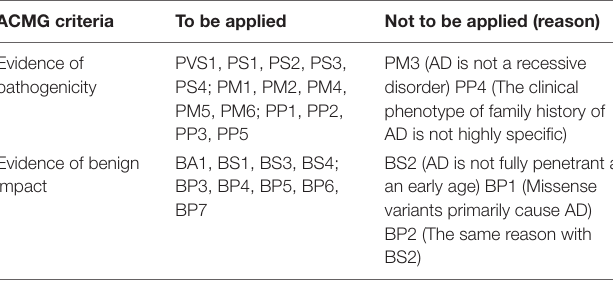
TABLE 1 | Relevance of ACMG criteria in